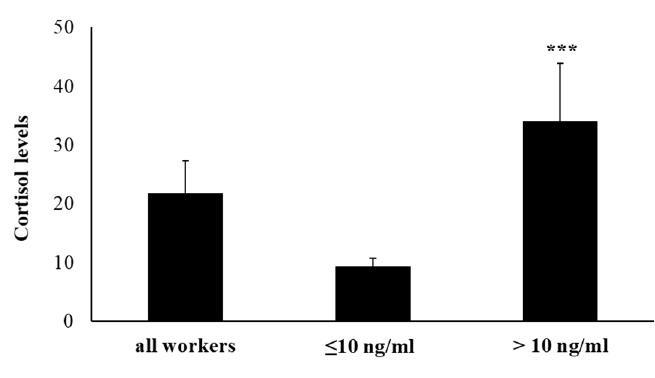
Figure 1. Salivary cortisol levels in all enrolled workers. Workers were divided into two groups based on salivary cortisol levels ≤ or > of 10 ng / mL. Data are reported as mean ± S.D. *** p -value ≤ 0.001.